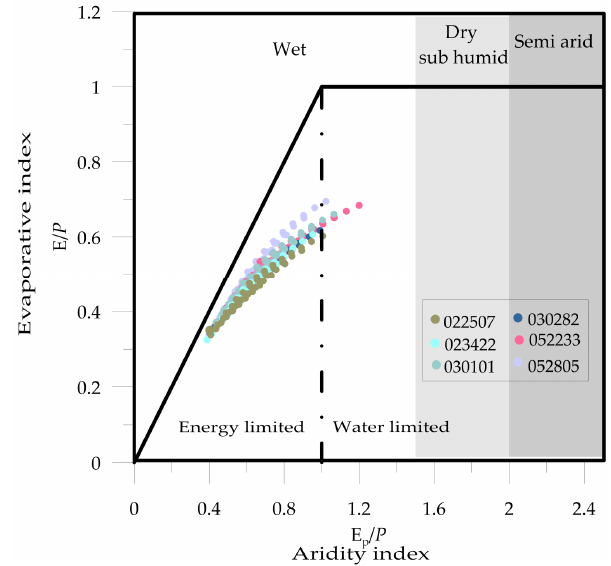
Figure 5. Budyko framework. The Y–axis represents the evaporative index, and the X–axis the aridity index. The response of each basin is represented by the colors shown in the box at the bottom right. From left to right, the climatic zones are shown: humid, dry sub–humid, and semi–arid in white, light gray, and dark gray, respectively. The vertical dotted line marks the division for energy–limited and water–limited zones.